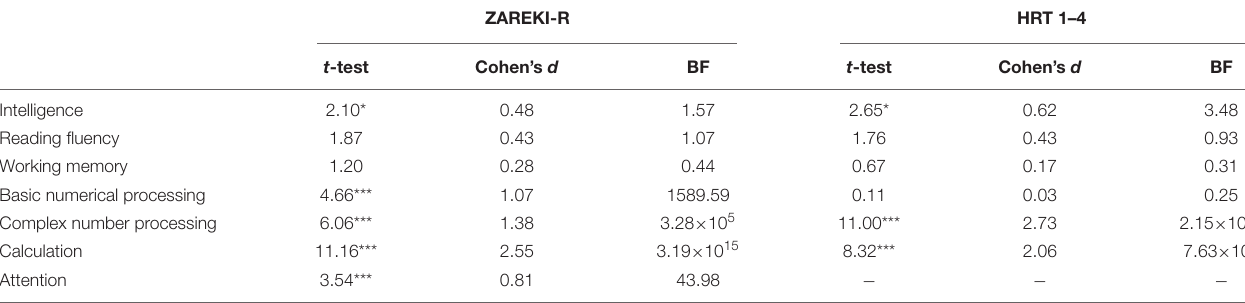
TABLE 5 | Subgroup mean comparison—clustered by constructs.